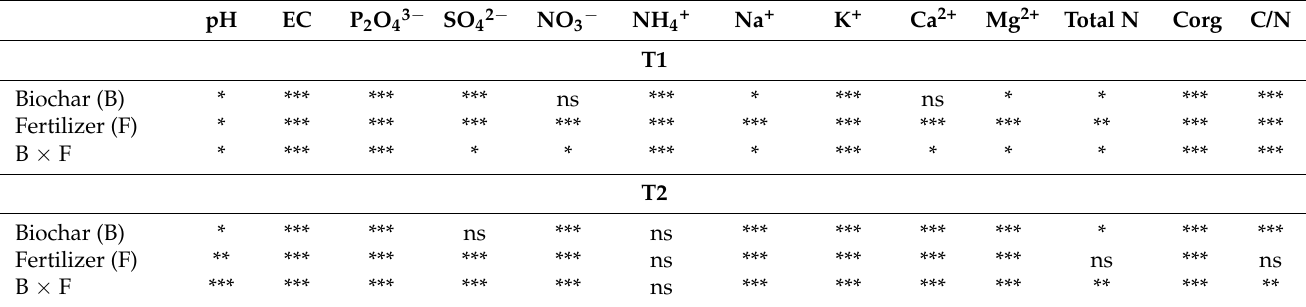
Table 3. Statistical p values of two-way ANOVA comparing differences of soil pH and